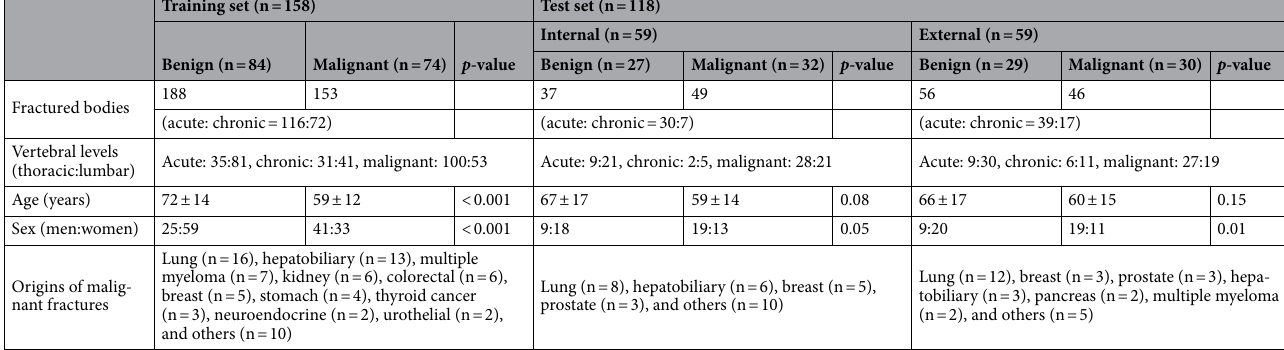
Table 2. Baseline demographic and clinical characteristics of patients in the training and test sets. Data for age are means ± standard deviation.